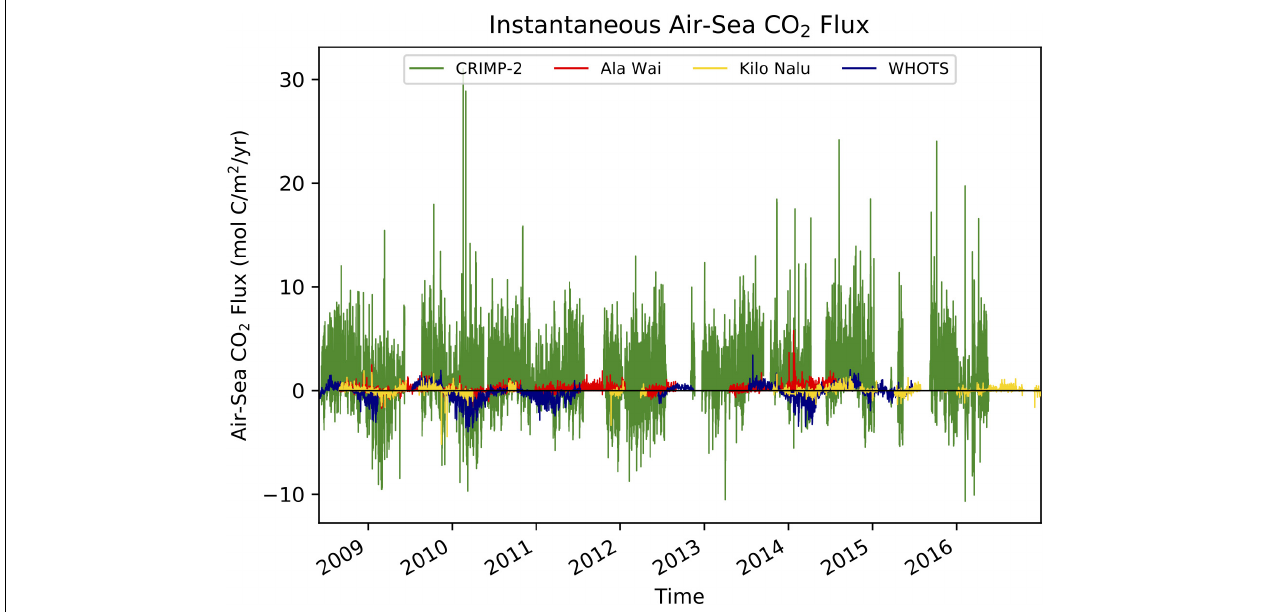
FIGURE 4 | Time-series of in situ (3-hourly) air-sea CO 2 fluxes at CRIMP-2, Ala Wai, Kilo Nalu, and WHOTS from June 2008 through December 2016 in units of mol C m − 2 yr − 1 . Positive values indicate a source of CO 2 to the